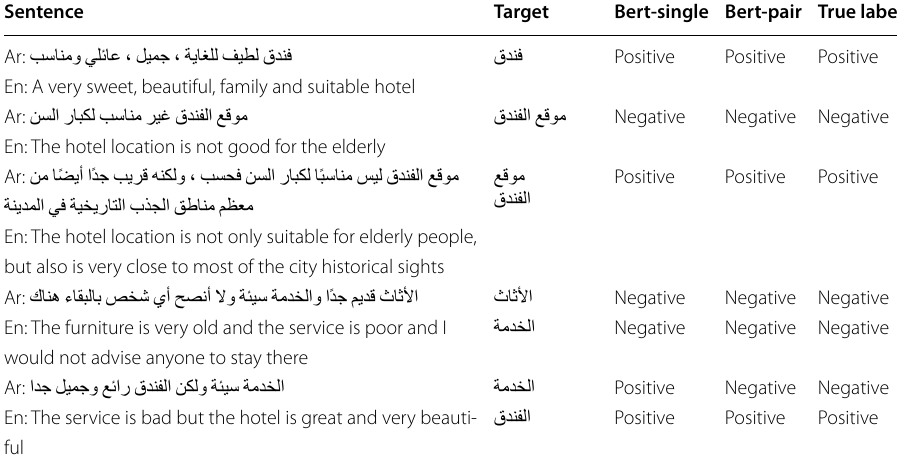
Table 4 Case study of different models on the Arabic hotel reviews dataset Sentence Target Bert‑single Bert‑pair True